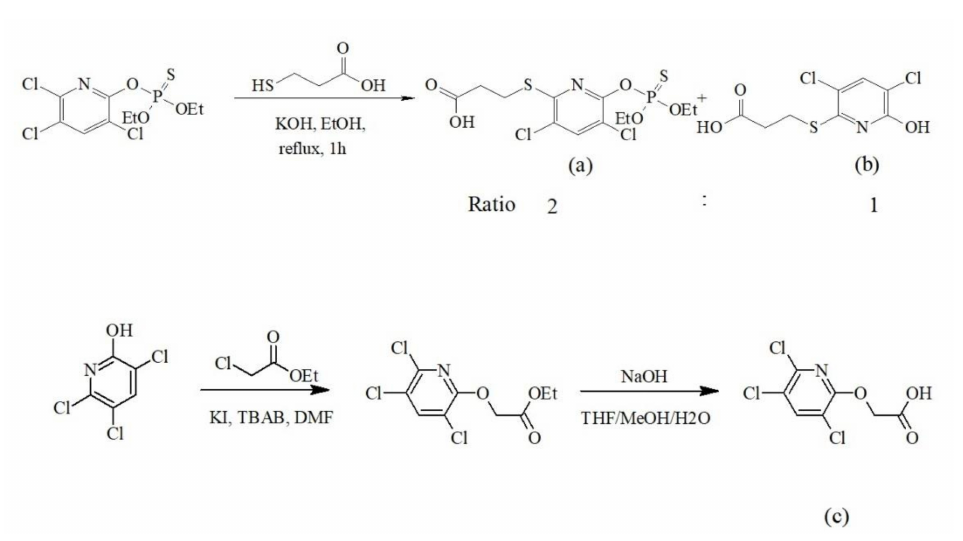
Figure 1. The synthesis of haptens was performed as previously described [32]. Compounds ( a ), ( b ), and ( c ) were separated by column